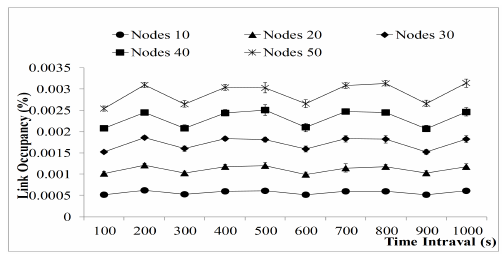
Figure 10: RTT measurement at the client (Avg.) Figure 11: Routing